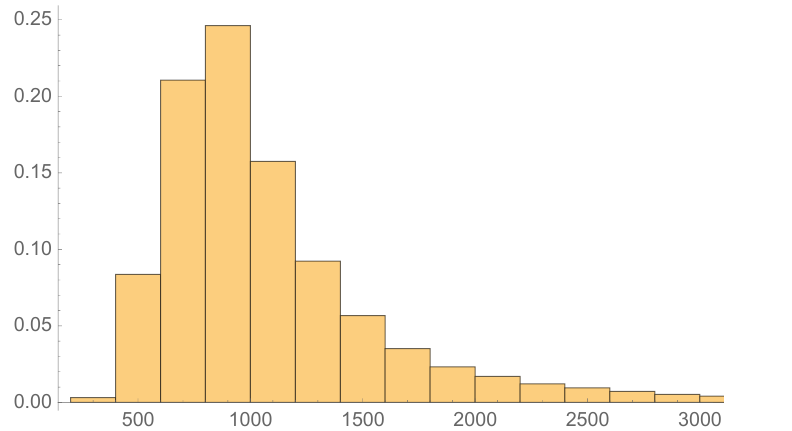
Figure 3 . Histogram (the integral is normalized to 1) of the sfermion mass m S in TeV for 14478 di(cid:11)erent (cid:12)ts consistent with proton lifetime